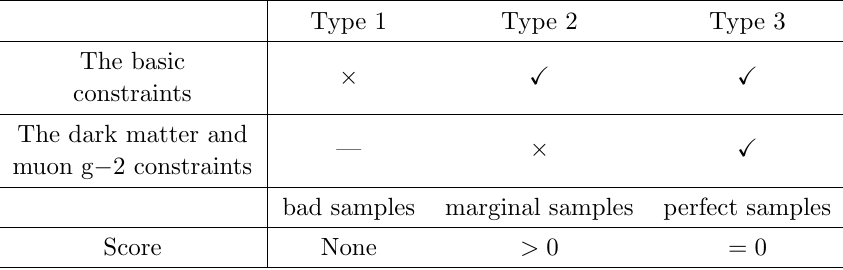
Table 1 . The three types of samples: the bad, marginal and perfect